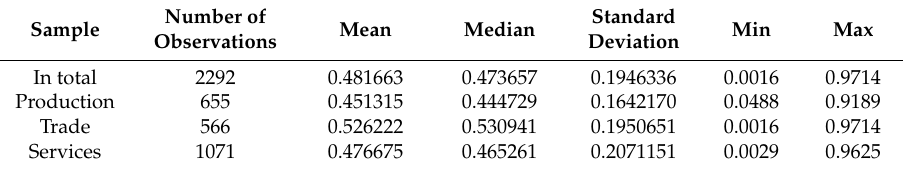
Table 2. Sample characteristics: debt capacity constraint (debt to total assets).